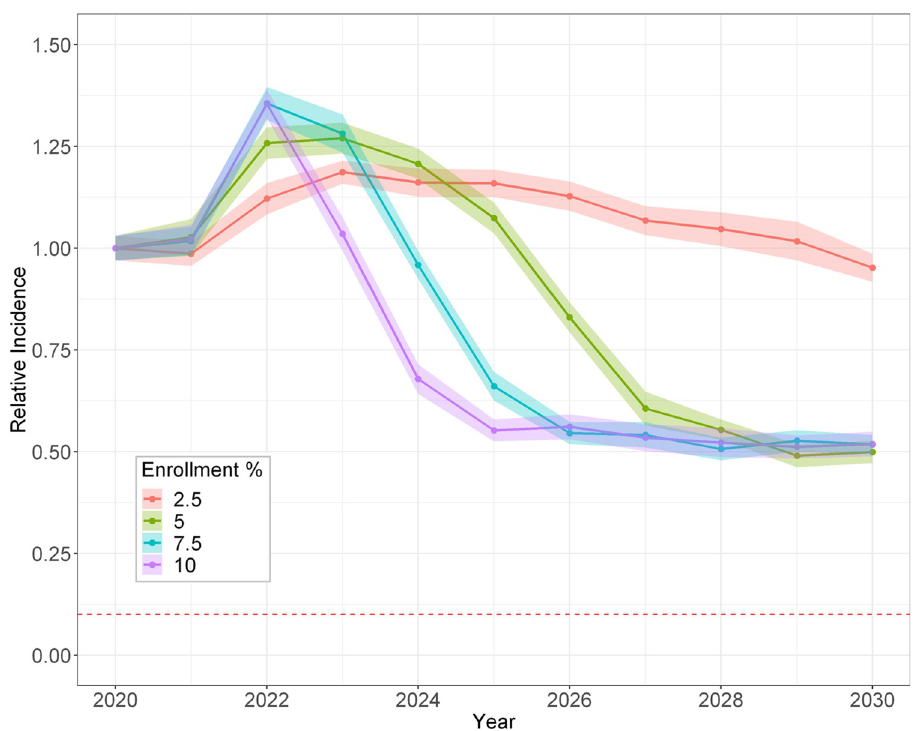
Fig 4. Projected mean incidence of new HCV chronic infections among PWID relative to the predicted 2020 incidence with only one treatment course allowed. Enrollment percent is DAA rate (e.g., enrollment of 10% is treatment of 100 per 1000 PWID per year) and treatment adherence of 90%. The ribbons represent the 95% confidence interval around the mean of 20 simulation runs. The horizontal red dashed line represents the WHO 2030 goal of 90% reduction in the incidence rate.